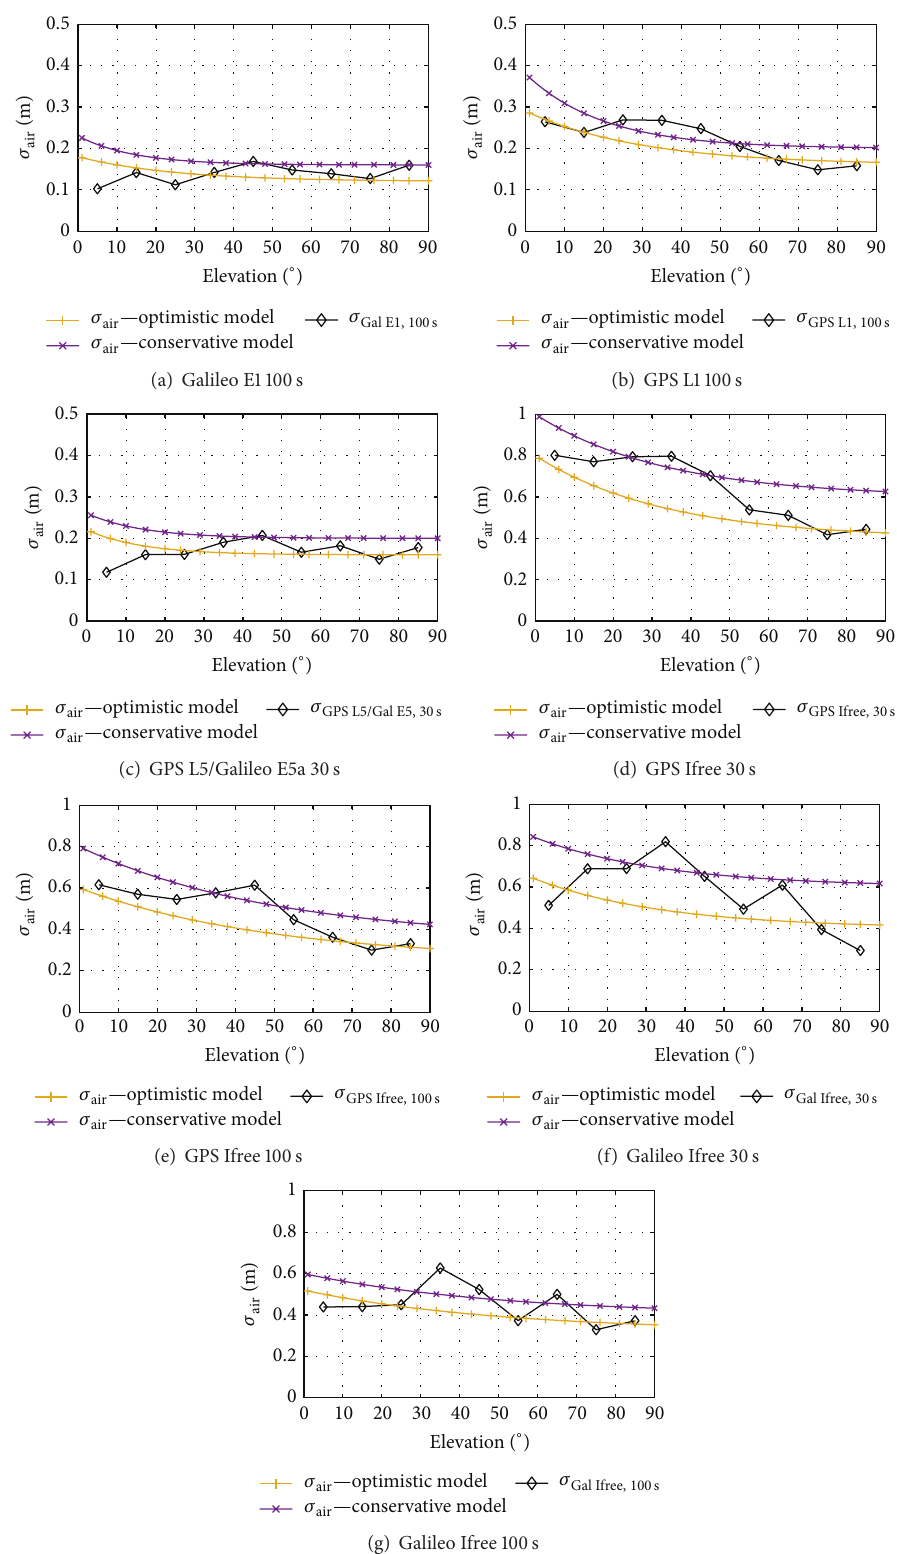
Figure 17: 𝜎 curves for different processing gnd